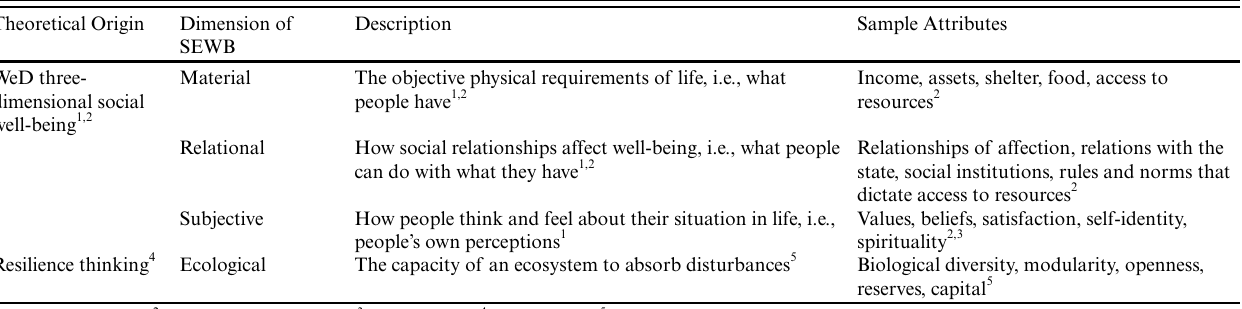
Table 1 . Description of the four dimensions of social-ecological well-being (SEWB) and sample attributes. WeD, Wellbeing in Developing Countries.